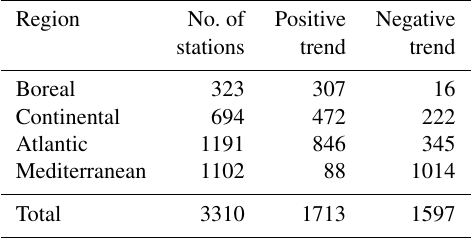
Table 2. Percentage of significant (i.e., 3310 stations) positive and negative trends in annual streamflow volumes in the European